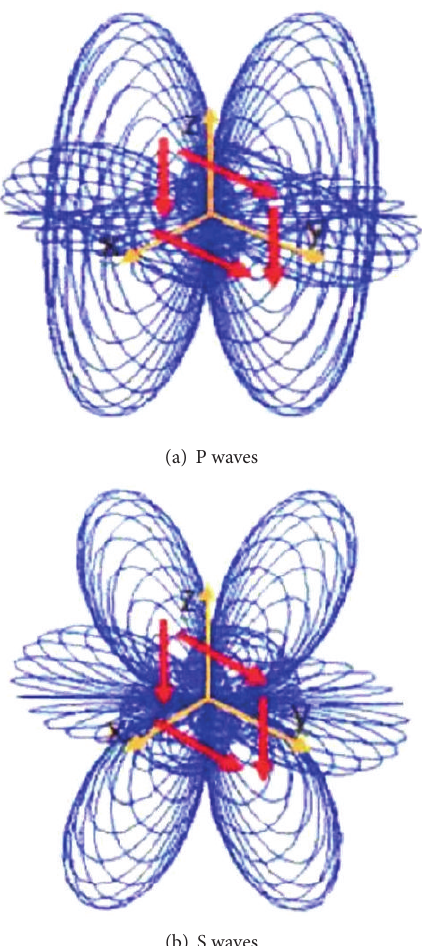
Figure 7: Diagrams of waves propagation from combination of two couples of forces with sum of moments equal to zero.